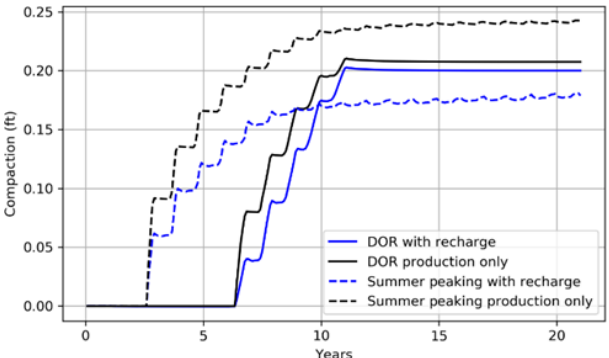
Figure 3. Compaction versus time for the DOR and summer peak- ing projects, comparing ASR simulations (recharge and production) to simulations with only